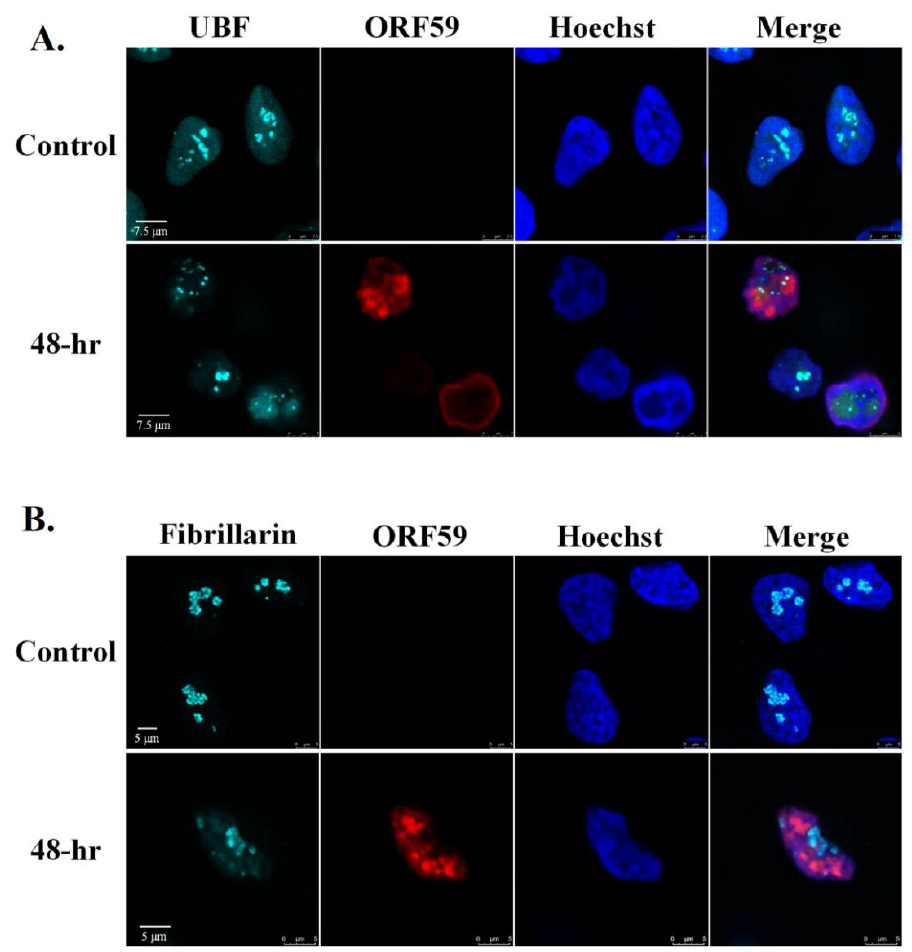
Figure 4. UBF partially colocalizes with viral replication compartments whereas Fibrillarin does not colocalize with replication compartments during lytic reactivation. BAC16-infected iSLK cells were treated for 48 h with 1 µ g/mL Dox and 1 mM n-Butyrate to induce lytic reactivation. Untreated infected iSLK cells were used as control. Cells were stained with anti-ORF59 and secondary Rhodamine-conjugated antibody. Cells were subsequently incubated with anti-UBF ( A ) or anti-Fibrillarin ( B ) and then incubated with anti-rabbit Cy5-conjugated secondary antibody. Chromatin was detected by Hoechst